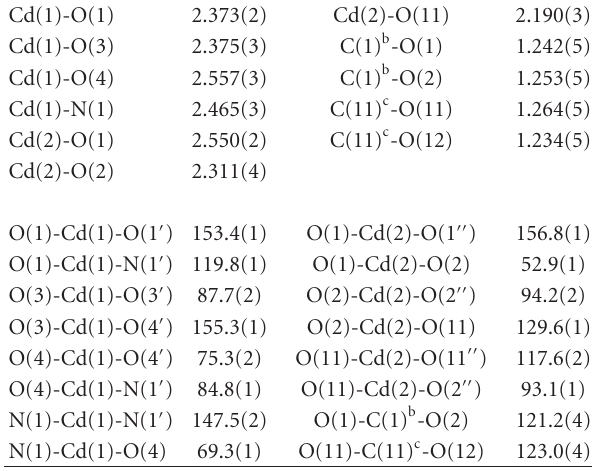
Table 1: Crystal data and structure refinement for complex 1 . Table 2: Selected bond lengths (˚A) and angles ( ◦ ) for complex 1 a